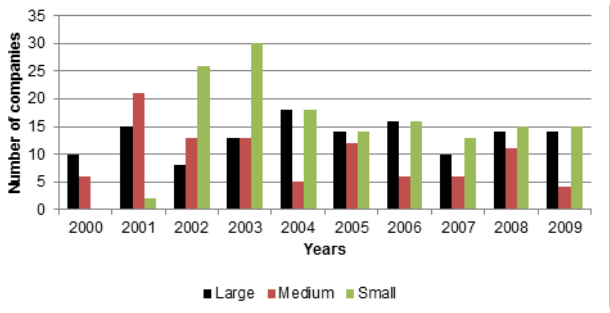
Figure 3: Number of companies repurchasing